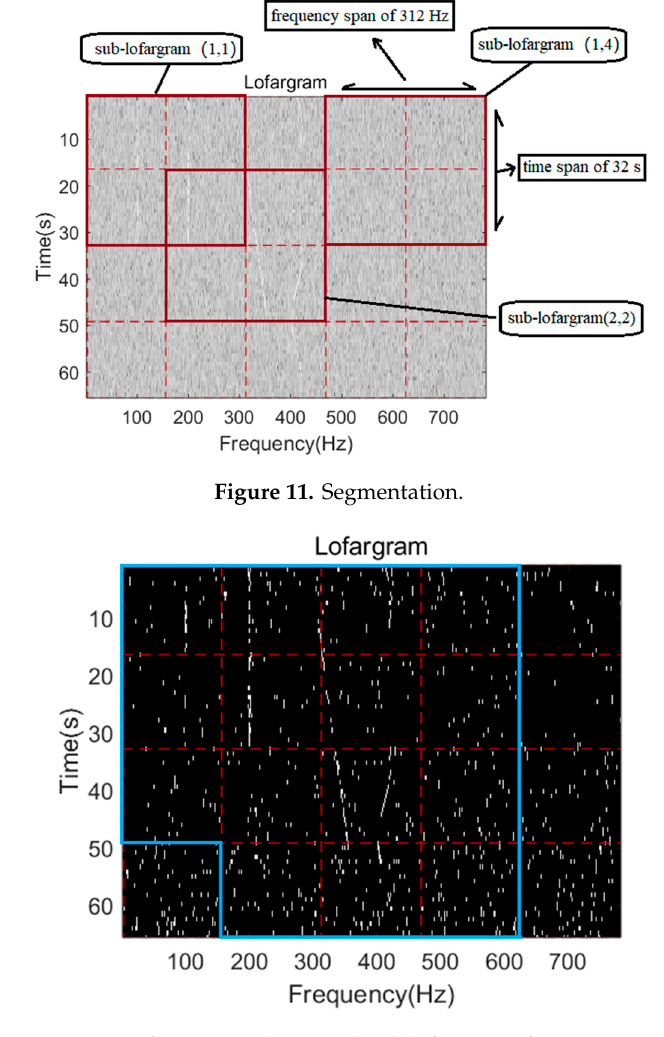
Figure 12. Lofargram and reserved sub-lofargram after screening.